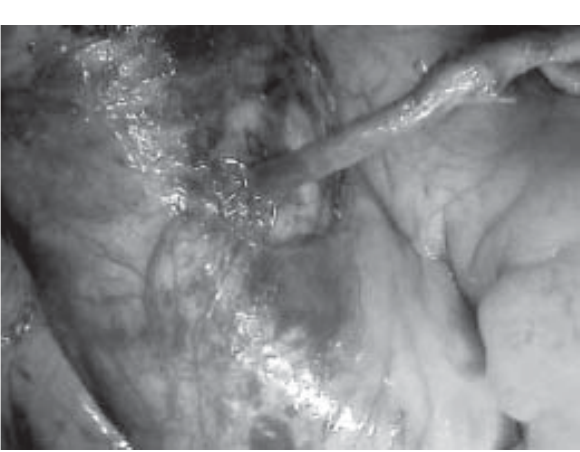
Fig. 4 – Final view of the aorto-saphenous anastomosis with the mechanical